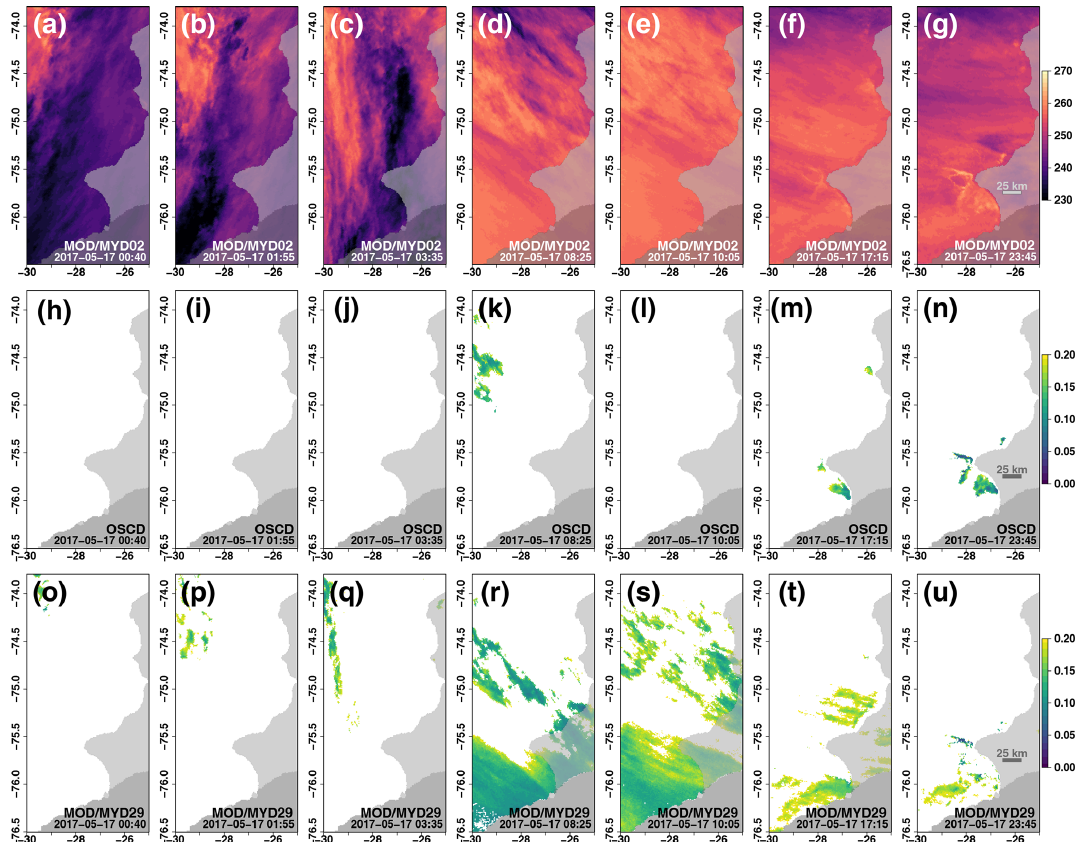
Figure 8. Compilation of MODIS swaths used for the computation of the data shown in Fig. 7: swath-based ice-surface temperature (IST in K; a–g ), resulting swath-wise thin-ice thickness (TIT in m) using OSCD (h–n) and MOD/MYD29 (o–u) data, respectively. Please note that the date format in this figure is year month day